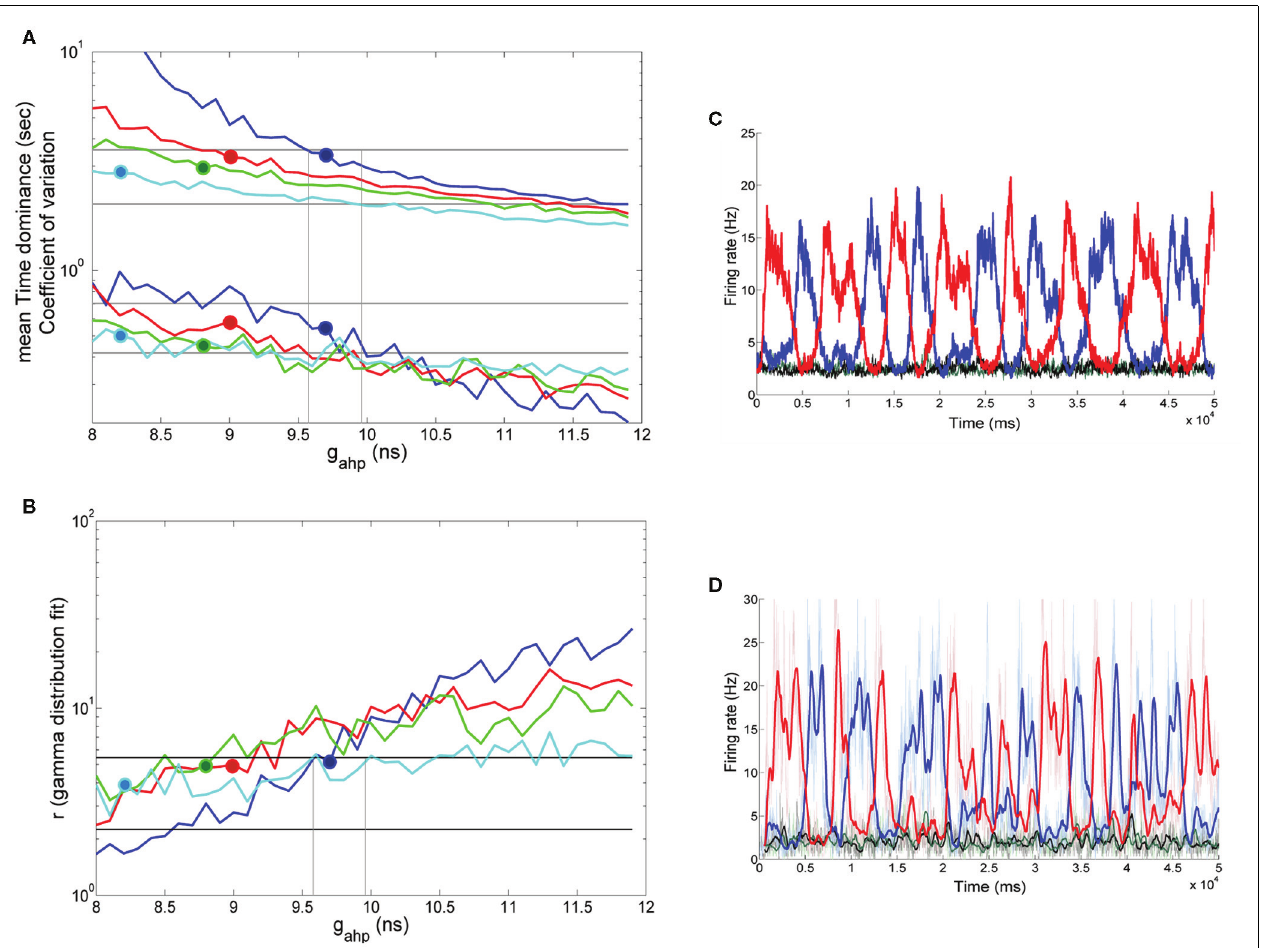
FIGURE 10 | Spike-frequency adaptation only to the excitatory pyramidal neurons of the network: Replicating the experimental data. (A) Mean time dominance and coefficient of variation as a function of neuronal adaptation for different levels of noise (blue: n = 0.01, red: n = 0.014, green: n = 0.016, and celestial: n = 0.019) for λ 1 = λ 2 = 50Hz. (B) Parameter r of gamma distribution fit to the distribution of dominance times as a function of neuronal adaptation for the same levels of noise as in (A) . In both (A,B) , horizontal lines denote the range that the experimental data define.Vertical lines are drawn at the bifurcation points where the system transits from a bistable dynamical regime to a mixed-mode oscillations and to an oscillatory regime. Blue, red, green, and celestial big circles at g ahp = 9.7nS, g ahp = 9nS,